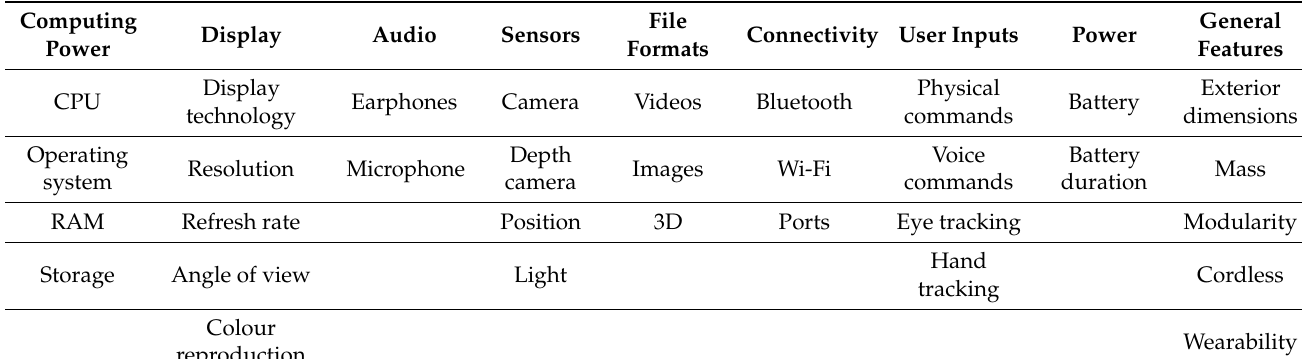
Table 1. Specifications from datasheets grouped into macro-specifications.